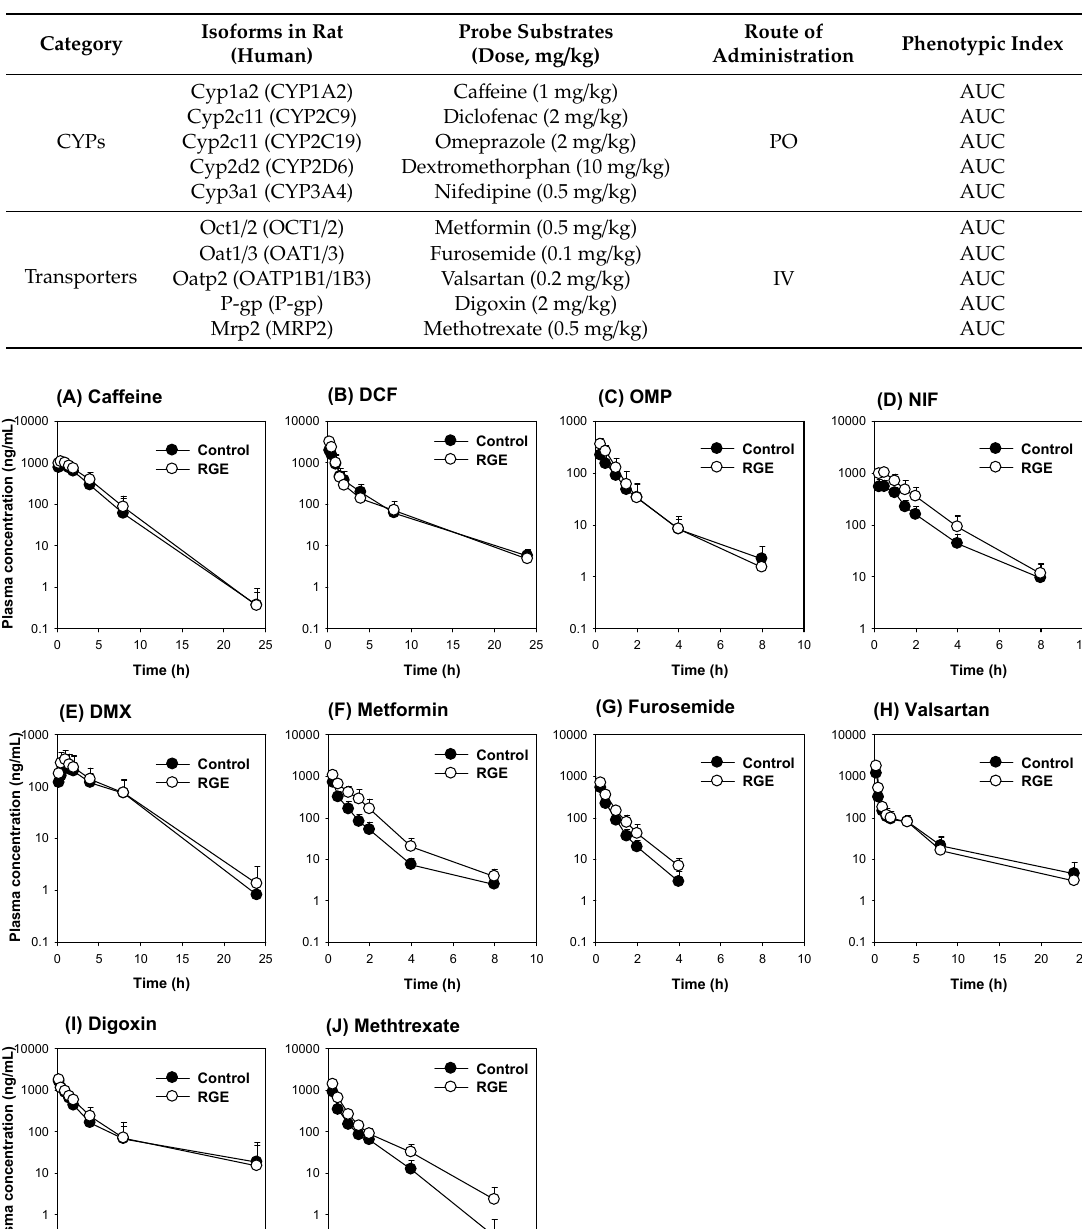
Table 9. The composition and phenotypic index of dual cocktail.